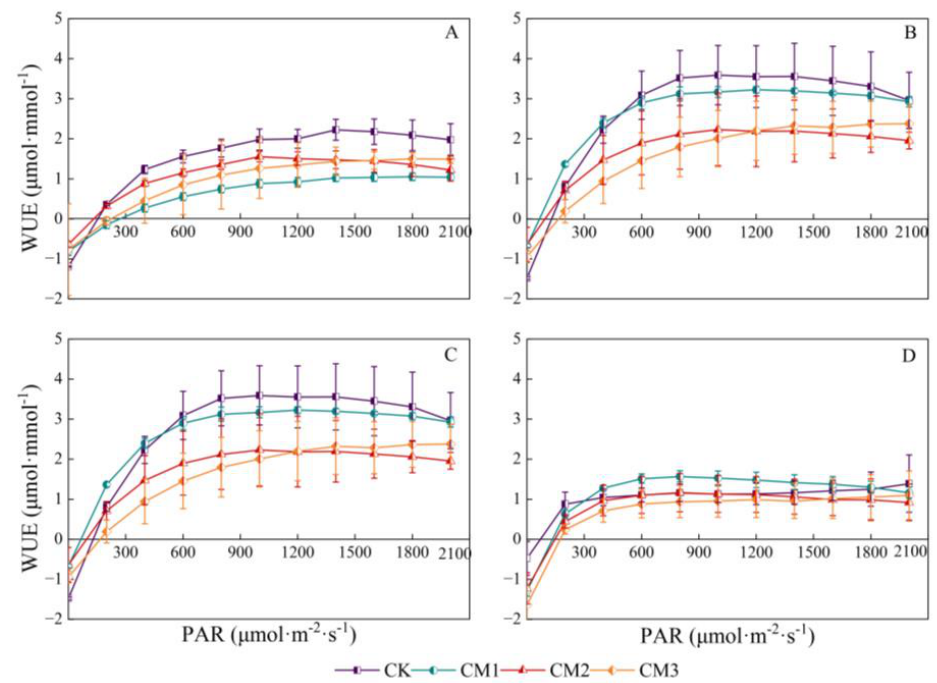
Figure 9. Light-response curves of cotton leaf instantaneous water-use efficiency (WUE, μmol·mmol −1 ) under different configuration modes. ( A ): seedling period; ( B ): budding period; ( C ): flowering and boll development period; ( D ): maturation